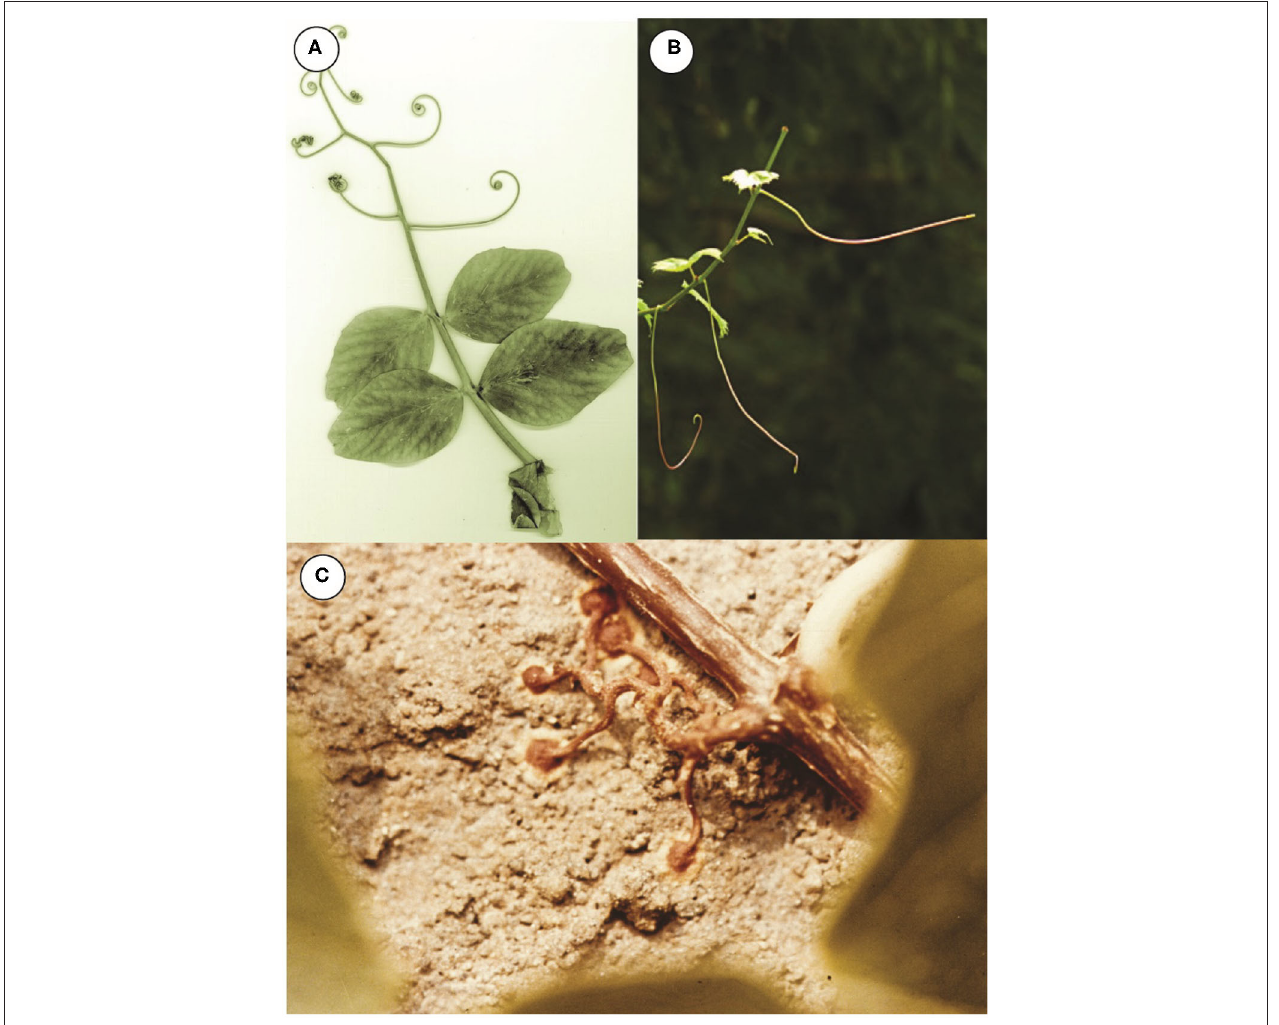
FIGURE 2 | Examples of clasping plant organs. (A) Terminal tendrils of a pea leaf ( Pisum ). (B) Axillary tendril-like stems of grape ( Vitus ). (C) Adventitious roots of ivy ( Parthenocissus ).